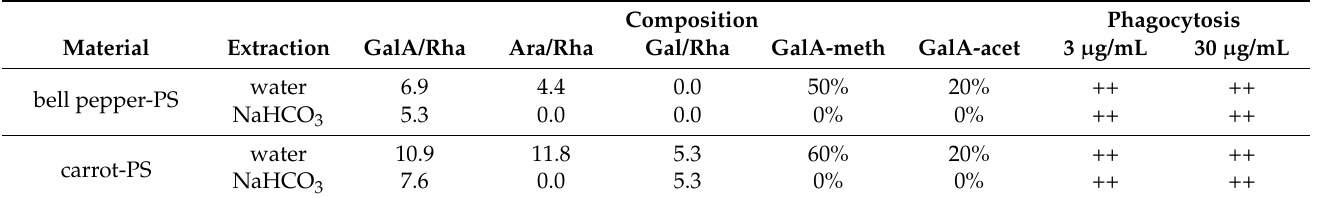
Table 2. Sugar composition relative to Rha signal based on 1 H-NMR data of bell pepper-PS and carrot-PS after extraction in hot water or bicarbonate (pH 7.5–8), and potency to enhance in vitro phagocytosis. Composition